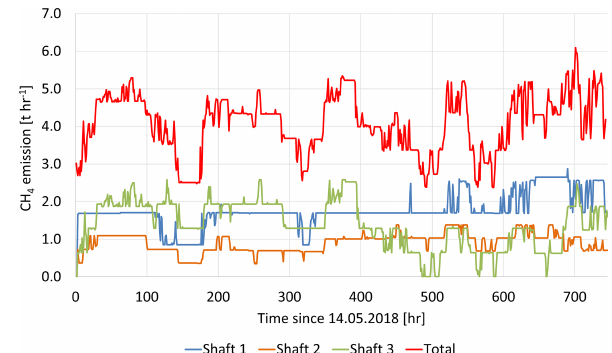
Figure 6. Detailed hourly emissions for the three shafts of the Pniówek mine and the entire